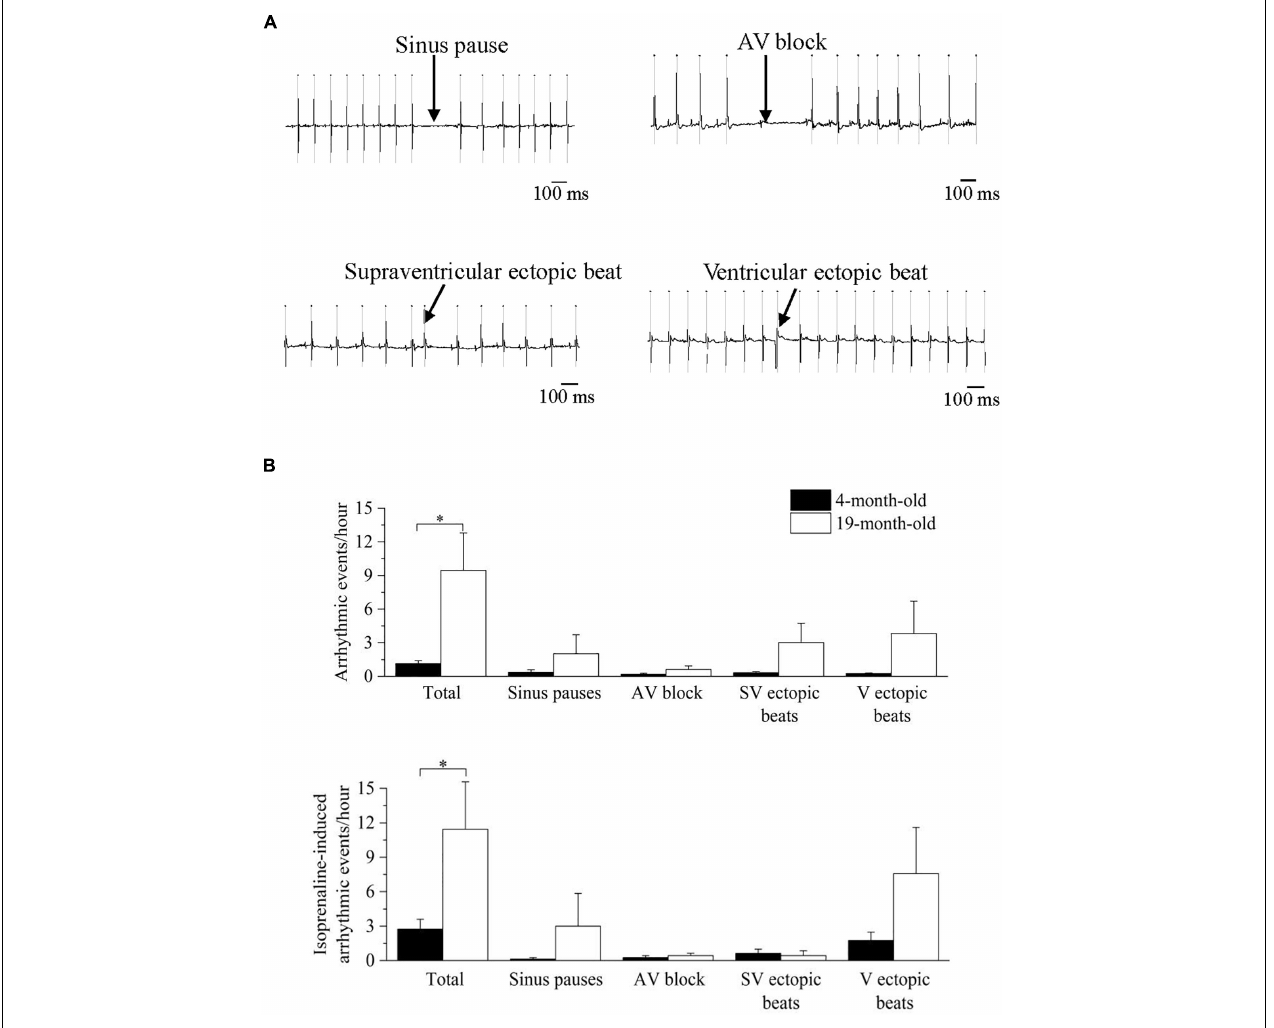
FIGURE 5 | Analysis and classification of spontaneous and induced arrhythmic events occurred in 4- and 19-month-old mice. (A) sample ECG traces of four different types of arrhythmic events: sinus pause, atrioventricular block, supraventricular ectopic beat and ventricular ectopic beat. (B) mean values of the spontaneous (top) and isoprenaline-induced (bottom) total and type-specific (sinus pauses, atrioventricular block, supraventricular ectopic beats and ventricular ectopic beats) arrhythmic events. Data are reported as mean ± SEM. Comparisons were evaluated by Student’s t -test, ∗ p <